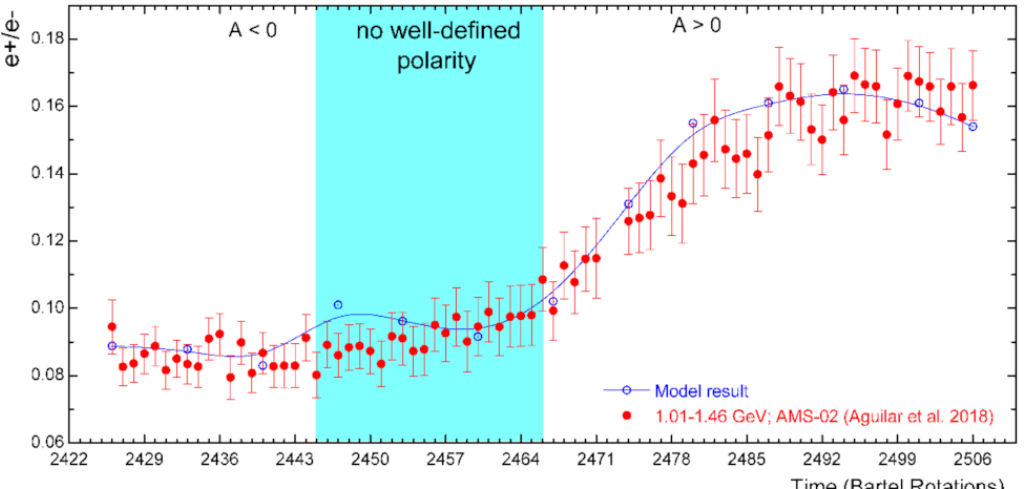
Figure 13. The simulated ( e + /e − ) ratio (blue circled point and smoothed line) as a function of time (solar activity) based on reproducing the AMS-02 electron and positron spectra [5] for this period from mid-2011 to mid-2017 shown here for 1.01–1.46 GeV in comparison with the observed ratio. Shaded band again indicates the period of no well-defined HMF polarity, with the A < 0 cycle before and the A > 0 cycle after this reversal